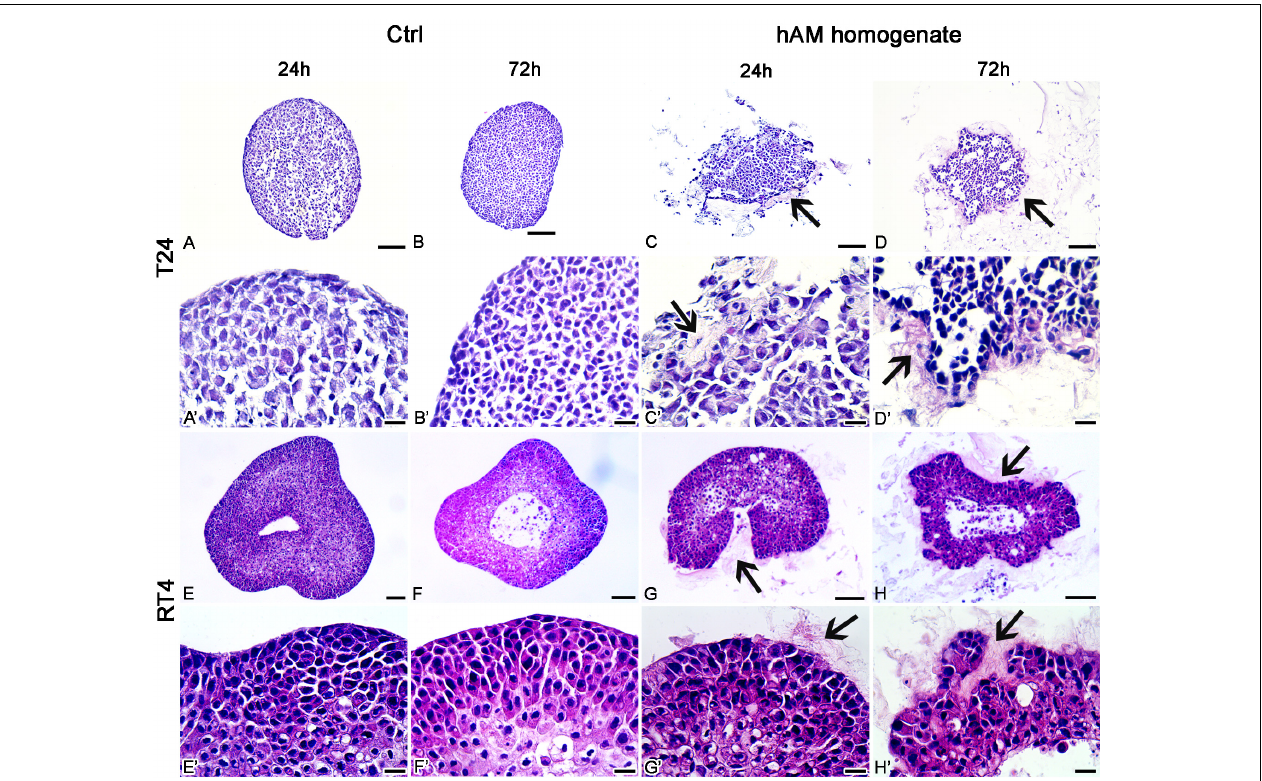
FIGURE 9 | Human amniotic membrane (hAM) homogenate disrupts the architecture of T24 and RT4 spheroids. (A–B ’ ) The T24 spheroids incubated in culture medium retained a compact spherical structure. (C–D ’ ) 24- and 72-h incubations in hAM homogenate resulted in the disrupted 3D structure of T24 spheroids. hAM homogenate adhered to the surface of T24 spheroids and was in some parts even incorporated into the spheroid. (E–F ’ ) The RT4 spheroids incubated in culture medium retained a compact spherical structure. (G–H ’ ) 24- and 72-h incubations in hAM homogenate resulted in the disrupted 3D structure of RT4 spheroids as the hAM homogenate adhered to the surface of RT4 spheroids and was in some parts incorporated into the spheroid. All data shown here were obtained from at least three independent replications of experiments using three biological samples of hAM; each experiment was performed in at least three technical repeats for each condition. Arrows–hAM homogenate. Scale bars: (A–D,E–H) 100 µ m, (A ’ –D ’ ,E ’ –H ’ ) 20 µ